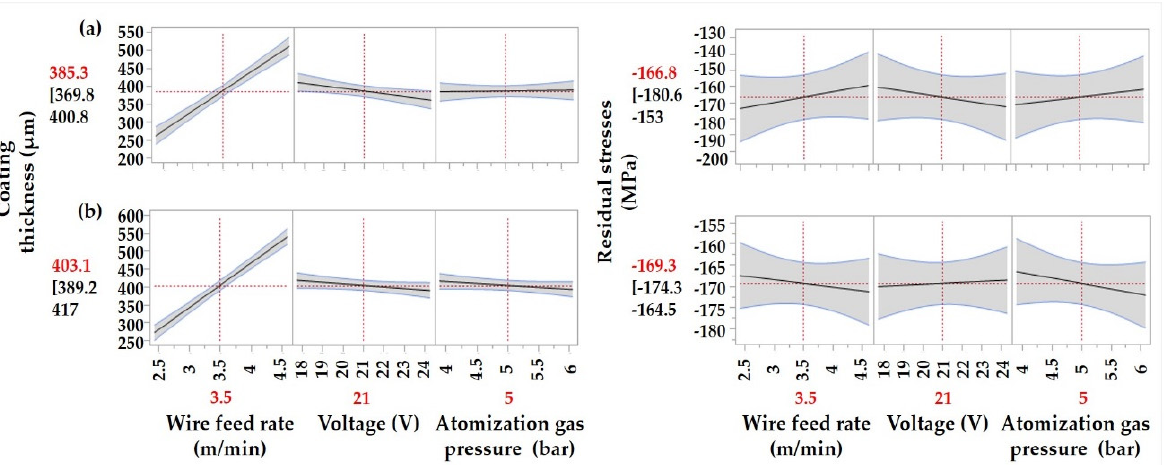
Figure 10. The effect of the process parameters on coating thickness and induced residual stresses ( a ) of compressed air sprayed coatings, ( b ) of argon sprayed coatings. ( a ) of compressed air sprayed coatings, ( b ) of argon sprayed